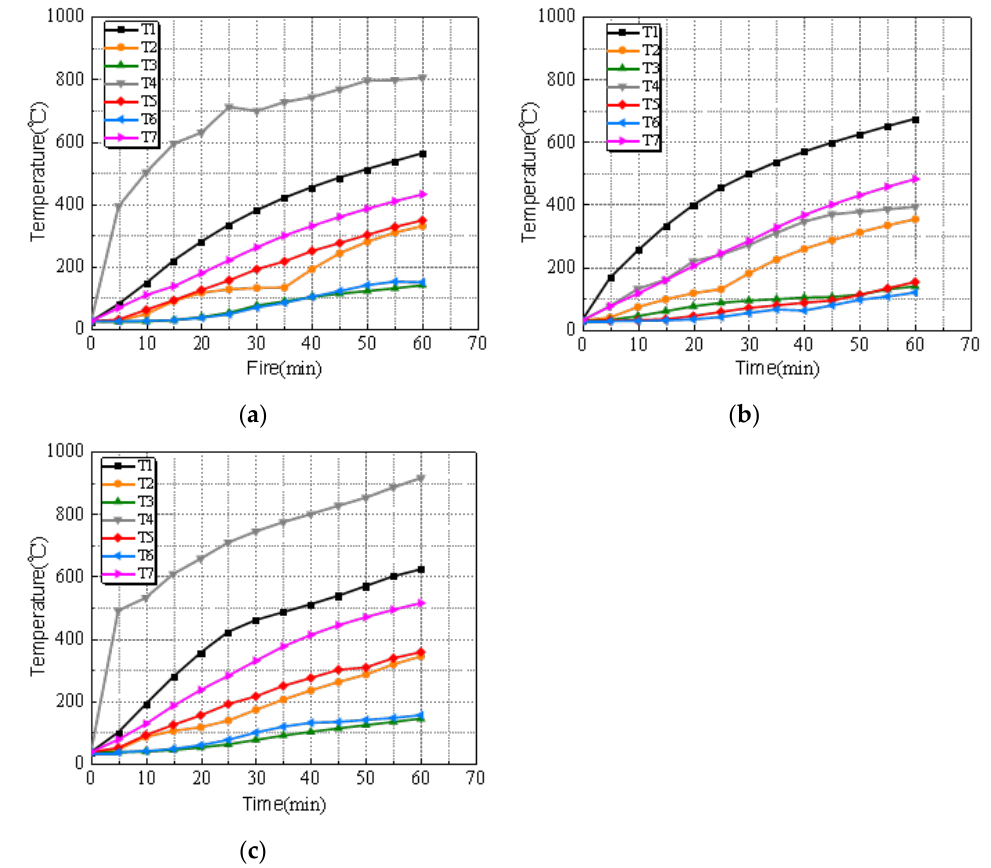
Figure 11. Temperature – time curves. ( a ) SW2; ( b ) SW3; ( c ) SW4.